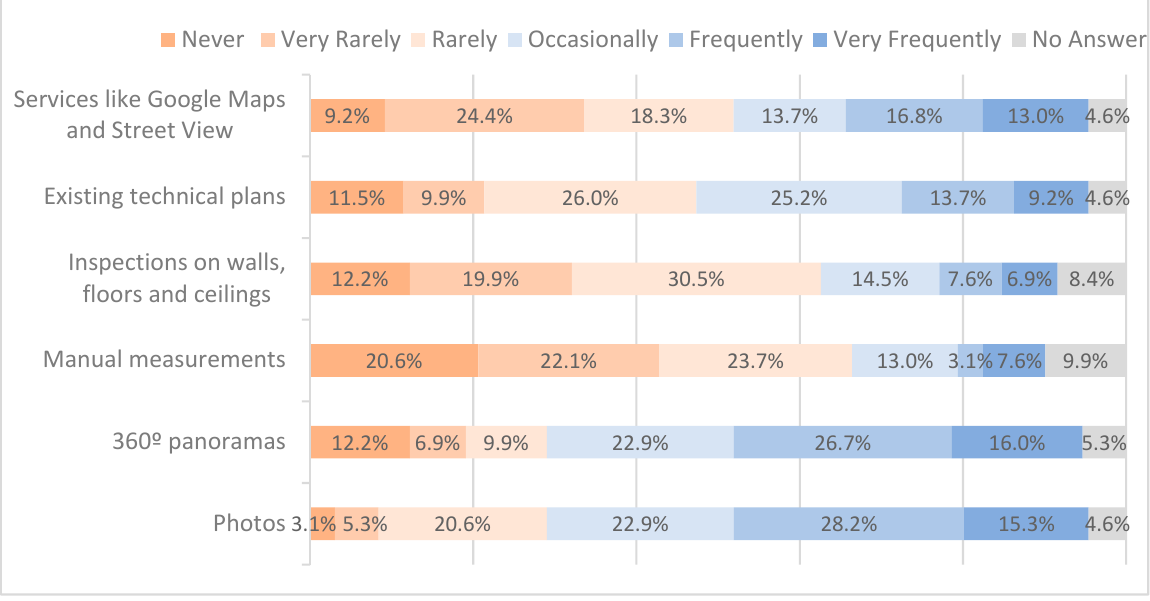
Figure 20. Chart showing the complementary sources used by the professionals in the modeling phase.